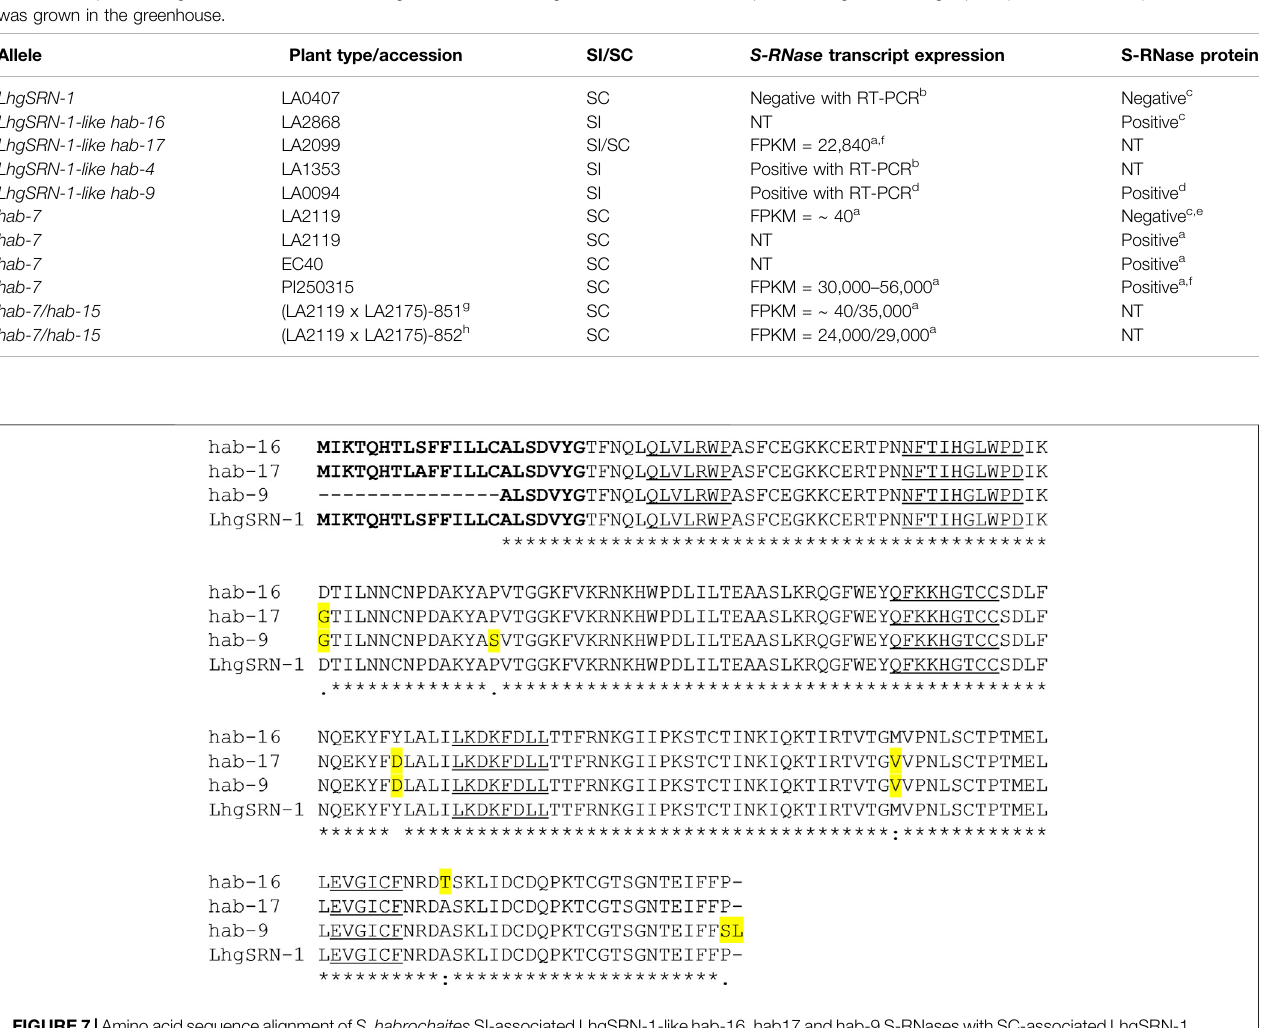
( Table 2 ), and their deduced amino acid sequences differ from LhgSRN-1 by between one and six amino acids ( Figure 7 ). The closely related hab-16 sequence has a single Ala/Thr substitution relative to LhgSRN-1, and the SI accession from which this sequence is derived (LA2868) is geographically close to the SC-2 group accessions ( Figure 4 ; Supplementary Table S4 ). In addition, LA2868 and SC-2 accessions display similar population structure (Landis et al., 2021). Together, the data strongly suggest that hab-16 is the ancestral functional allele of LhgSRN-1 .